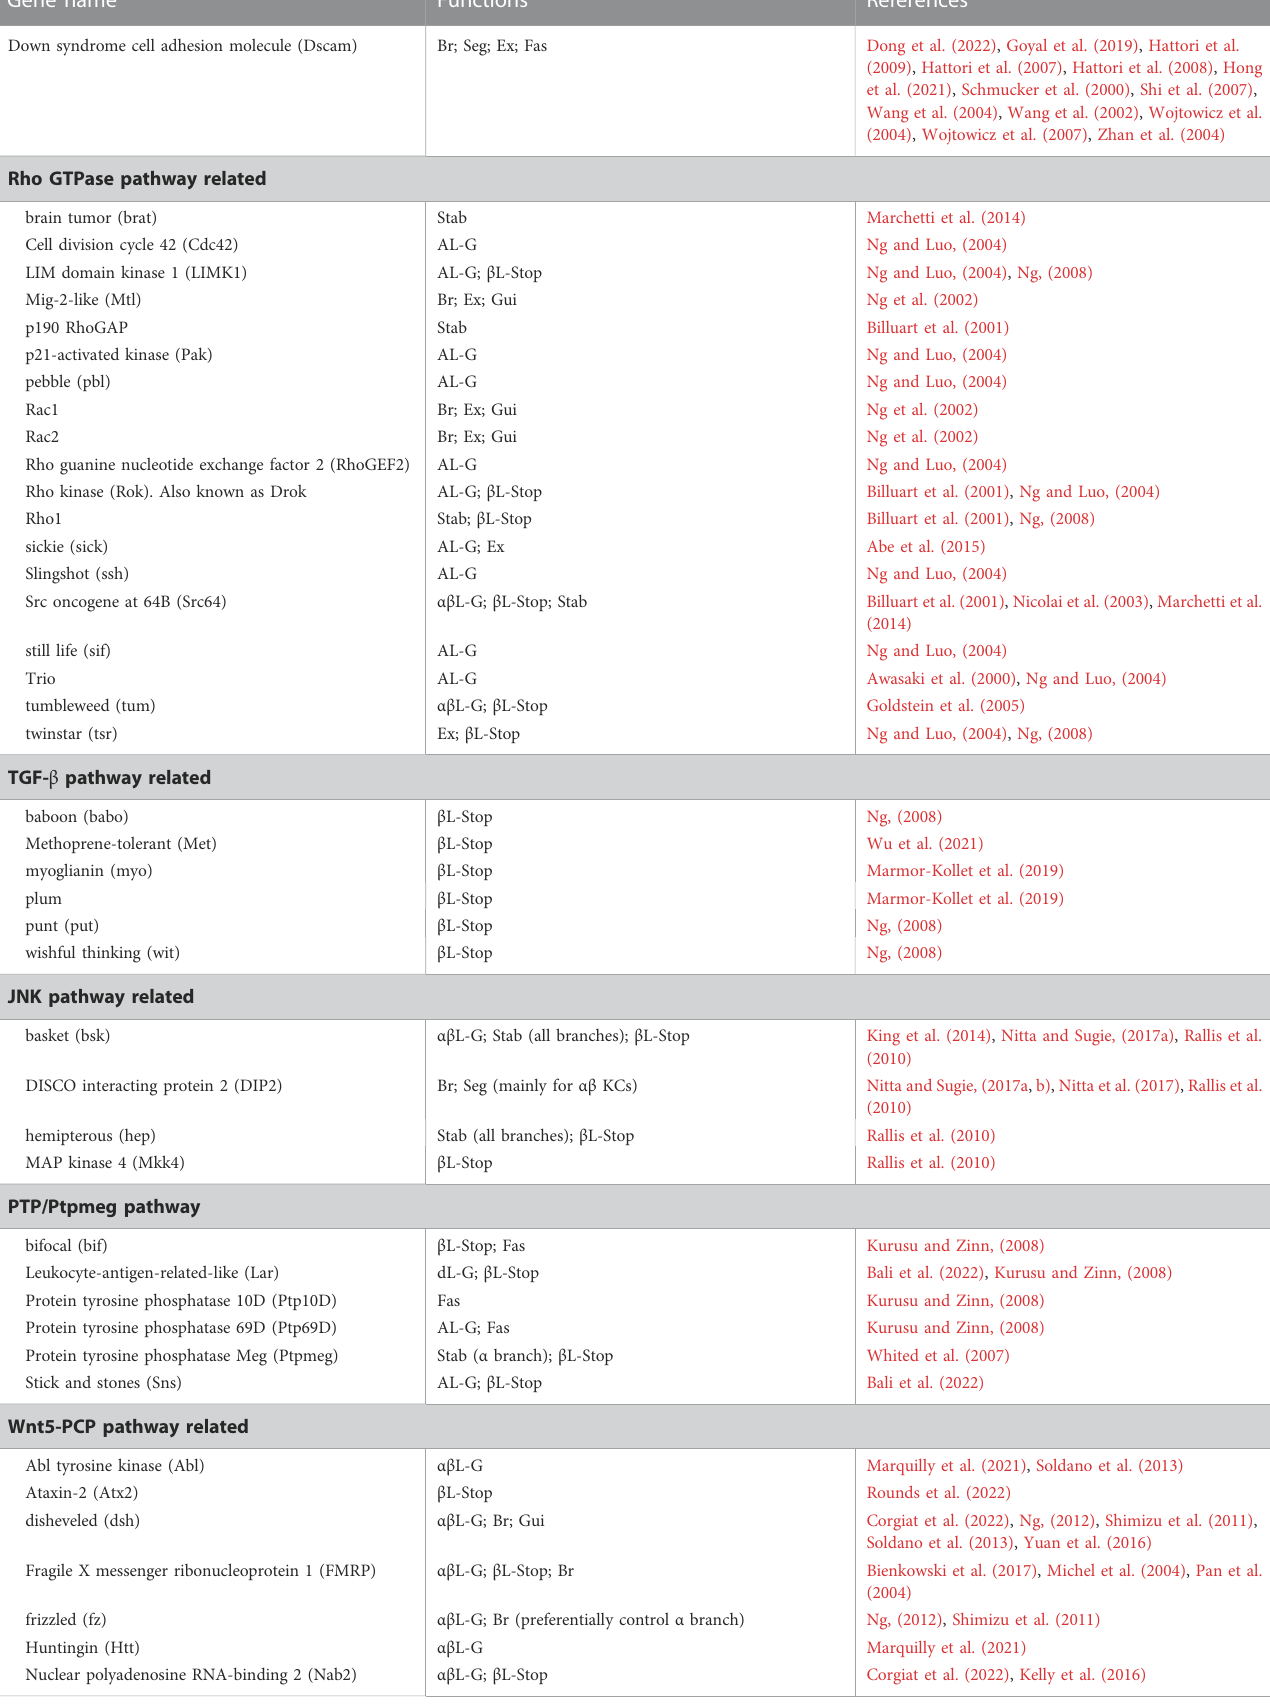
TABLE 1 Genes involved in the guidance and morphogenesis of KC